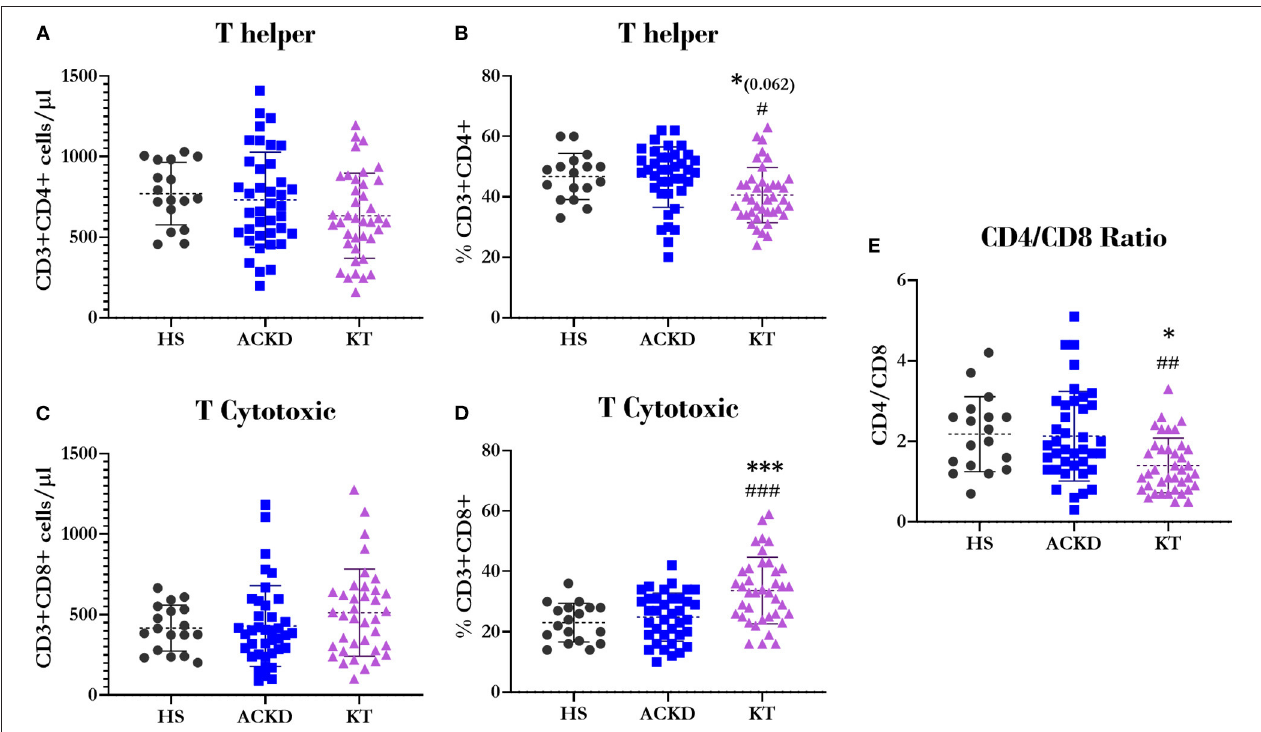
FIGURE 4 | Description of T lymphocyte subpopulations. Number Ψ (A) and percentage Ψ (B) of T-helper lymphocytes (CD3+CD4+); number Ψ (C) and percentage Ψ (D) of T-cytotoxic lymphocytes (CD3 + CD8 + ); relationship between helper and cytotoxic lymphocytes Ω (E) (CD4/CD8 ratio) in healthy subjects (HS), patients with advanced chronic kidney disease (ACKD), and patients with kidney transplantation (KT). * p ≤ 0.05, *** p ≤ 0.001 vs. HS; # p ≤ 0.05, ## p ≤ 0.01, and ### p ≤ 0.001 vs. ACKD. Statistical analysis: Ψ ANOVA (Tukey test). Ω ANOVA (Games–Howell test). ANOVA, analysis of variance.